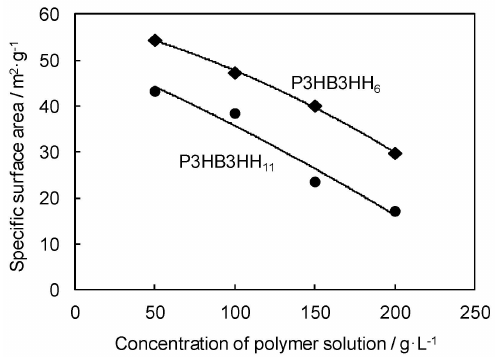
Figure 4. Relationship between concentration of polymer solution and specific surface area of P3HB3HH x